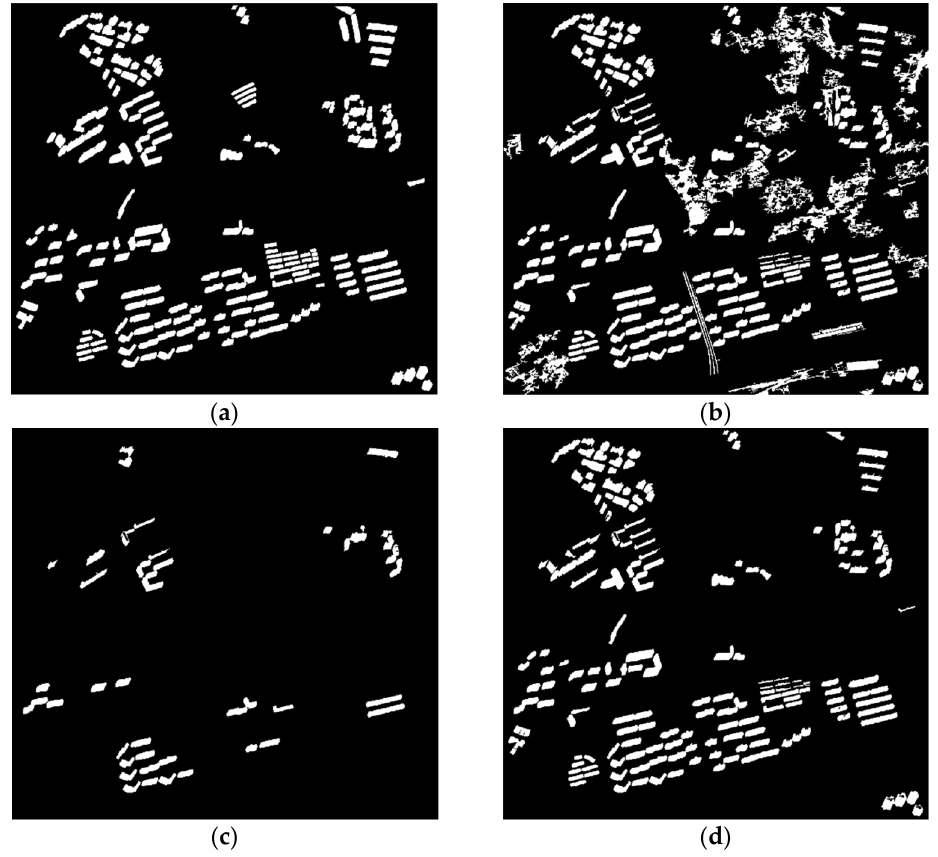
Figure 11. HRB detection results from Site 3. ( a ) Reference data; ( b ) HRB detection result by MBI; ( c ) HRB detection result by MBI with shadow intensity [42]; and ( d ) HRB detection result by MBI with digital maps. Table 6. Accuracy of HRB detection for Site